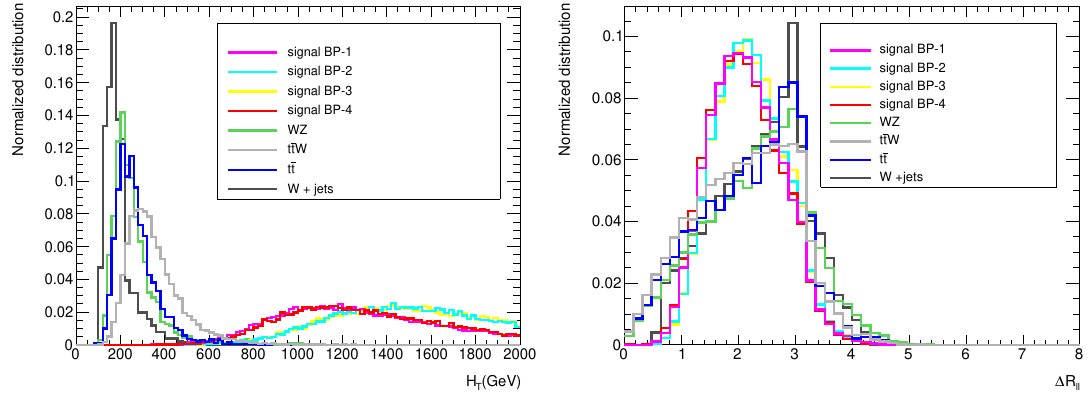
Figure 13 . Distribution of H T and (cid:1) R between leading and sub-leading leptons for the four signal BPs and backgrounds in case